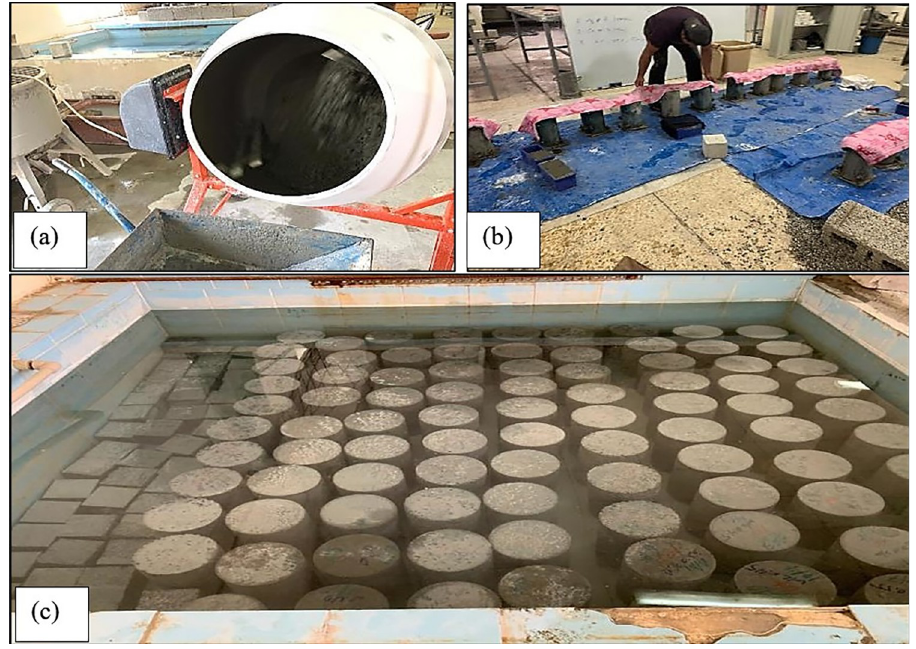
Fig 2. Preparation of specimens: (a) Mixing, (b) Casting and covering, and (c) Curing.